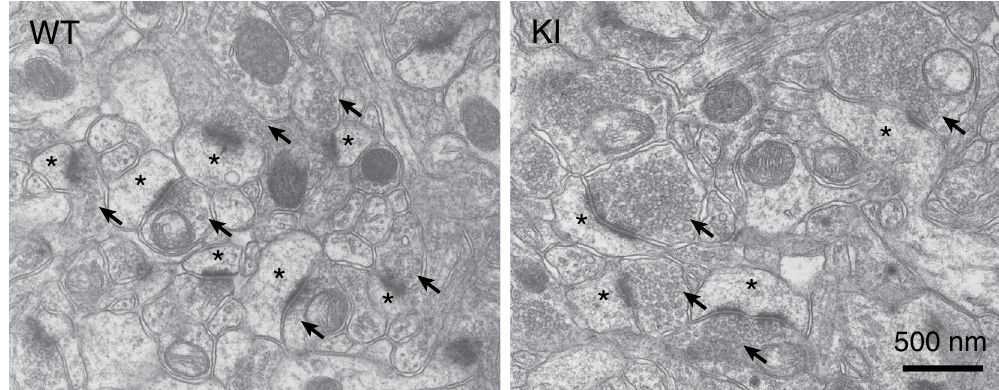
Figure 2. Representative electron micrographs of the hippocampal CA1 region in WT (left) and KI (right) mice. Arrows ( ↑ ) and asterisks ( * ) indicate excitatory presynaptic terminals and spines, respectively.